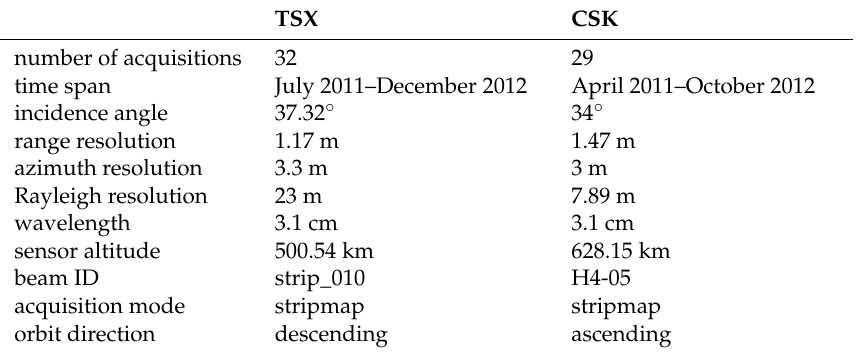
Table 1. Detected single and double PSs for single-look (SL) and multi-look (ML) sup-GLRT. TSX